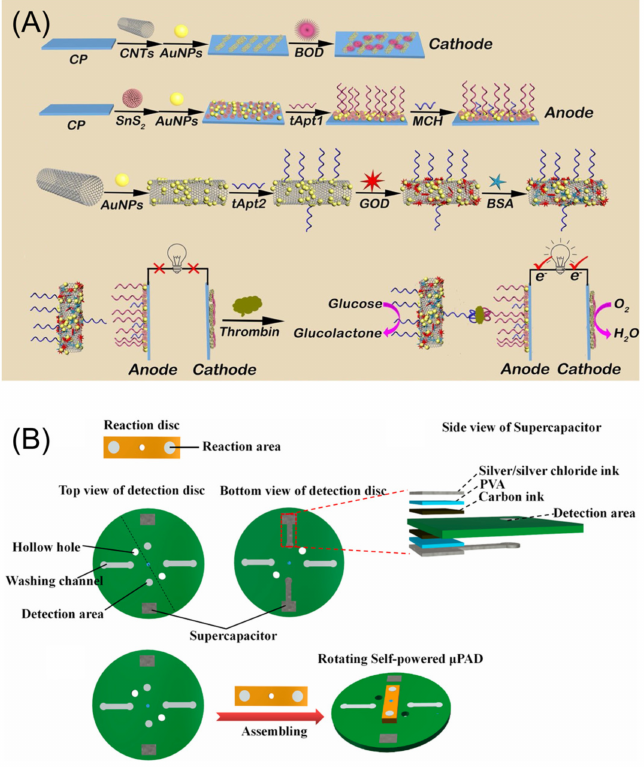
Figure 9. Schematic illustration of electrochemical sensors. ( A ) Fabrication processes of CNTs functionalized cathode and TBA1 modified anode of the thrombin sensor. Adapted with permission from Ref. [94]. Copyright (2019), Elsevier. ( B ) The multilayered structure of rotating Self-powered enzymatic biofuel cell-based sensor. Adapted with permission from Ref. [95]. Copyright (2021),